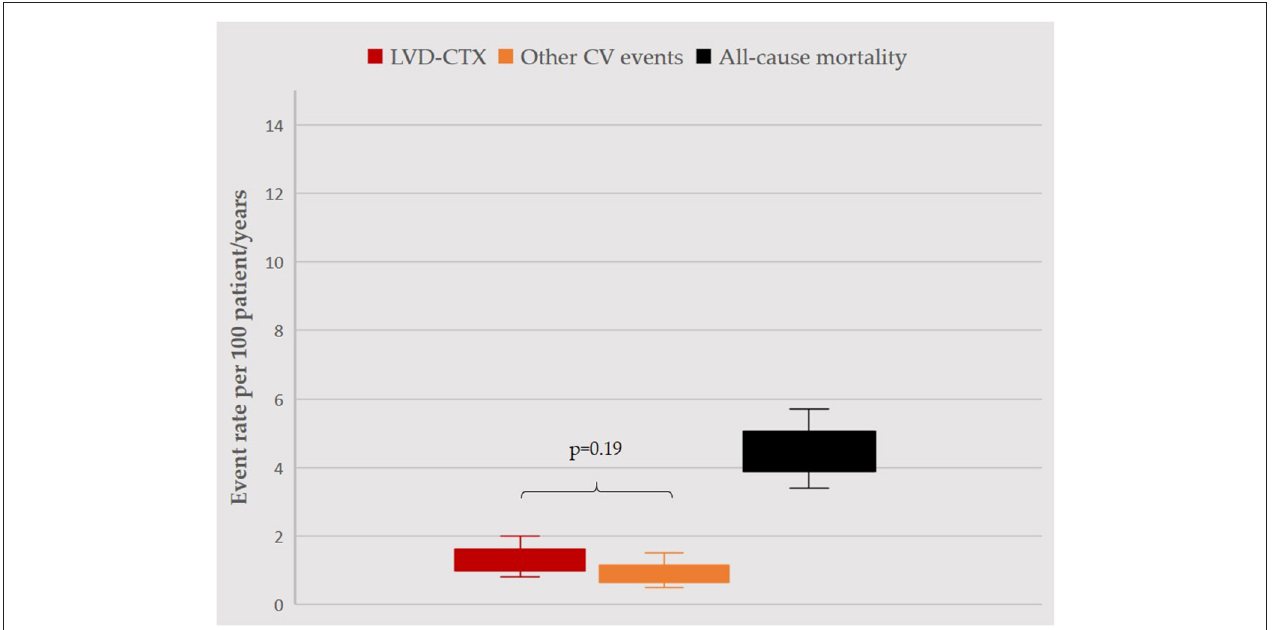
FIGURE 1 | Incidence rate of events during follow-up. Incidence rates per 100 patient/years, with confidence intervals, for LVD (red), other CV events (orange) and mortality (black) are displayed. LVD and other CV events occurred with similar rates ( p = 0.19). Rate of mortality was significantly higher as compared to other events (in both cases, p < 0.05), yet overall survival rate was > 95%. For the purpose of this analysis, follow-up was censored at occurrence of any event (1207.2 patient/years). LVD, left ventricular dysfunction; CV,